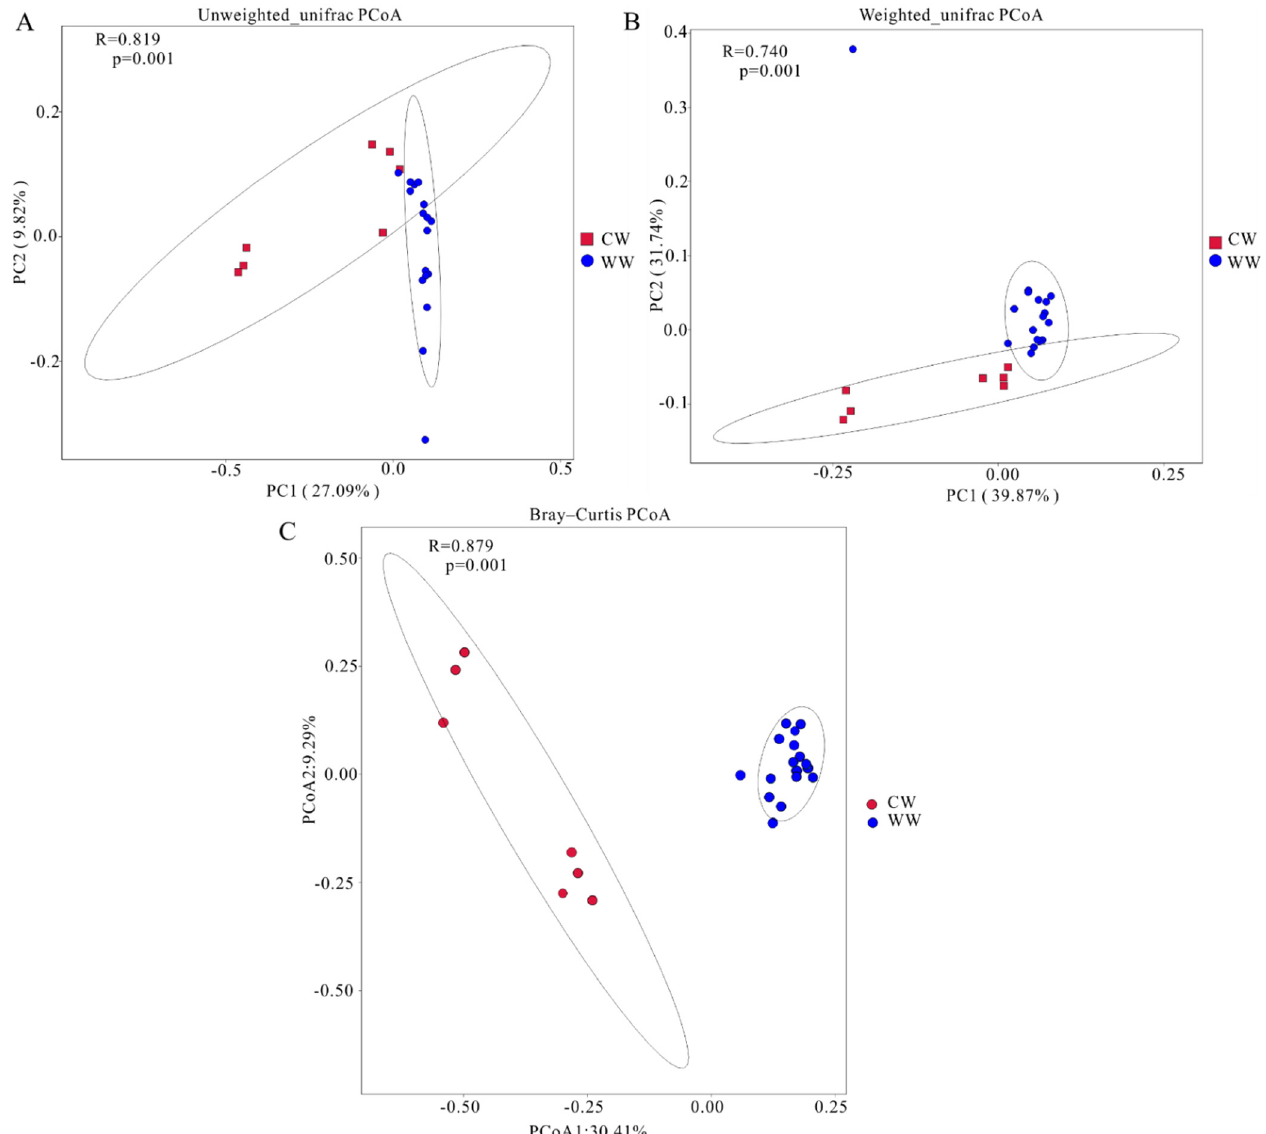
Figure 3. Principal coordinate analysis (PCoA) plots of gut microbiota analysis. PCoA was used to extract main elements by sorting eigenvalues and eigenvectors from multidimensional data. ANOSIM calculated by different arithmetics (R > 0 indicates that the grouping is effective). ( A ) Unweighted UniFrac; ( B ) weighted Unifrac; ( C ) Bray–Curtis. Distance of samples reflects similarity of gut microbiota community composition.